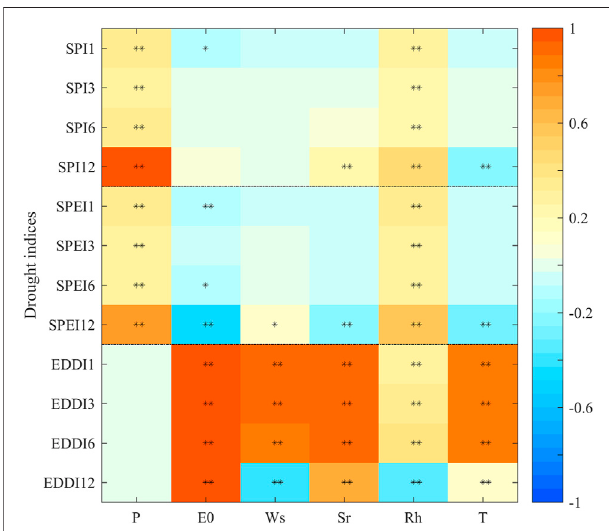
FIGURE 4 | Correlation between the 1, 3, 6, and 12 months of the SPI, SPEI, EDDI, and climate variables such as precipitation (P); temperature (T); wind speed (Ws); solar radiation (Sr); relative humidity (Rh); and evaporative demand (E 0 ) (a single asterisk represents the signi fi cance level less than 0.05 ( p < 0.05); double asterisks mean p < 0.01, respectively).